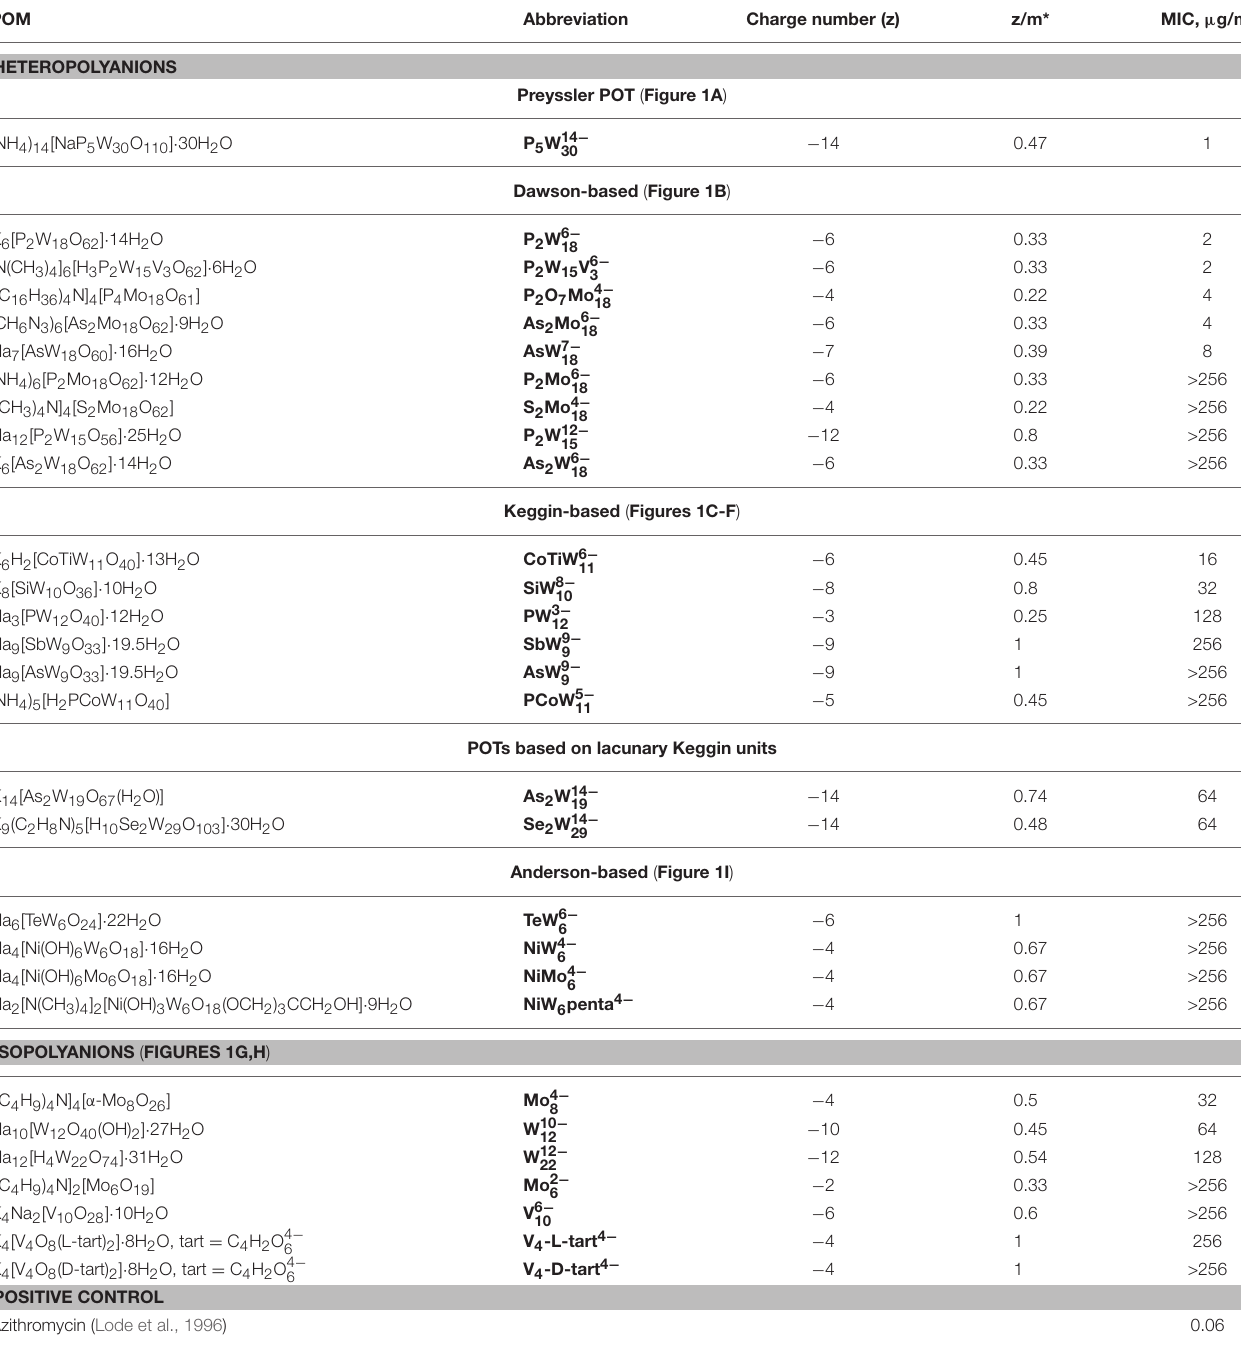
TABLE 1 | Minimum inhibitory concentration (MIC) of POMs against the M. catarrhalis (ATCC 23246). POM Abbreviation Charge number (z) z/m* MIC, µ g/ml HETEROPOLYANIONS Preyssler POT ( Figure 1A